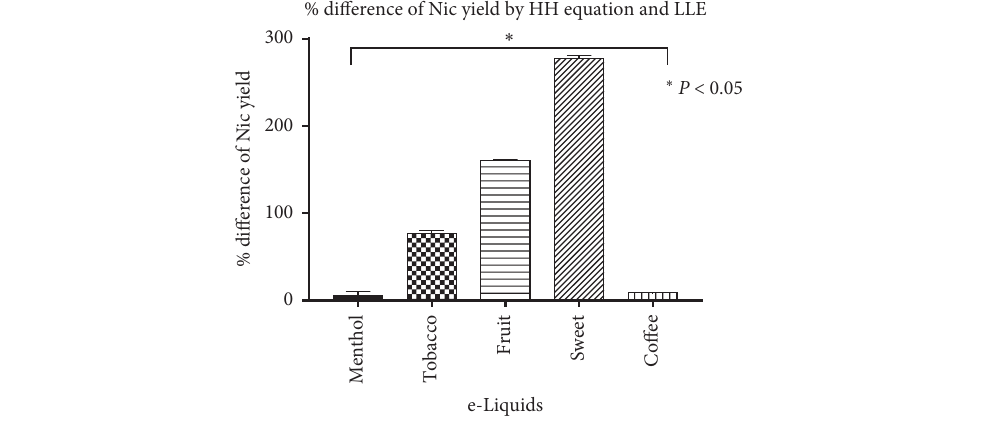
Figure 6: Percentage difference of free base nicotine (Nic) yield of e-liquid samples by HH equation vs. LLE (toluene-water extraction) ( ∗ P < 0 . 05; statistical analysis was carried out using GraphPad Prism